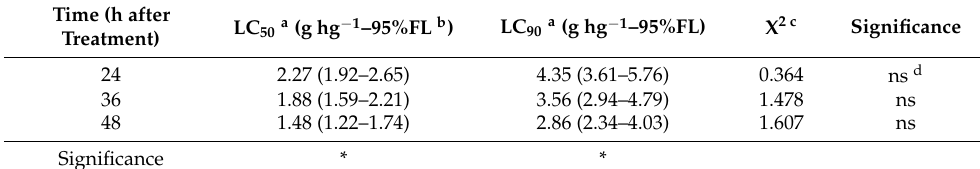
Table 2. Toxicity of sweet orange essential oil nano-emulsion against Aphis gossypii .